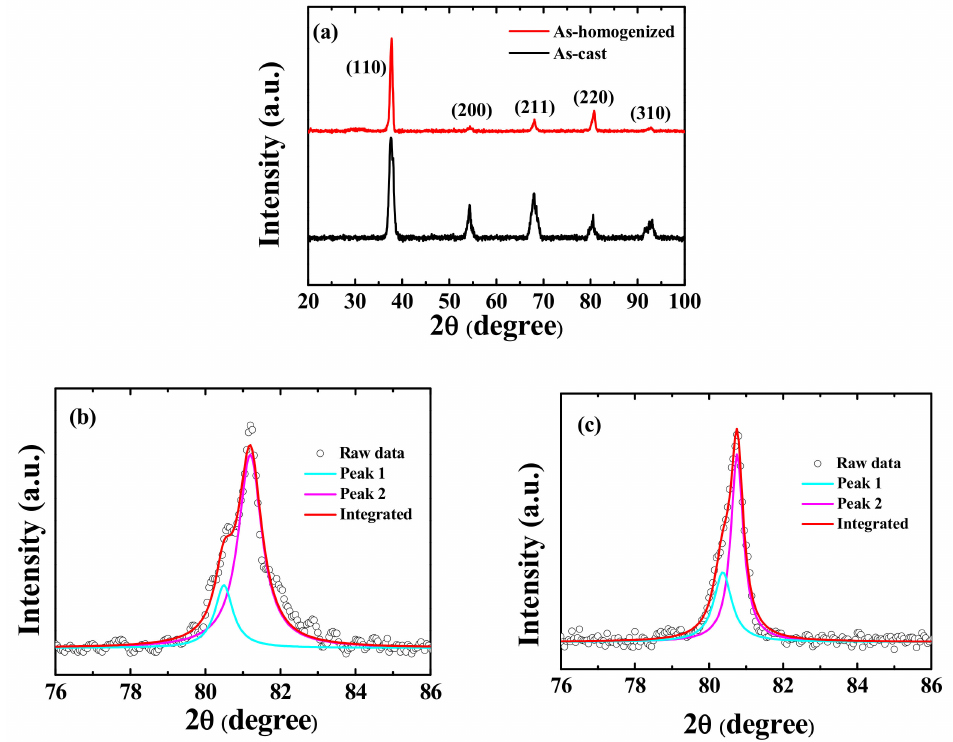
Figure 1. ( a ) The X-ray di ff ractometry (XRD) analysis of the as-cast and as-homogenized Ti 25 Zr 25 Nb 25 Ta 25 alloys, ( b ) the enlargement of the (220) peak profile and the fitting curves for body-centered cubic (BCC)1 and BCC2 of the as-cast sample, and ( c ) the enlargement of the (220) peak